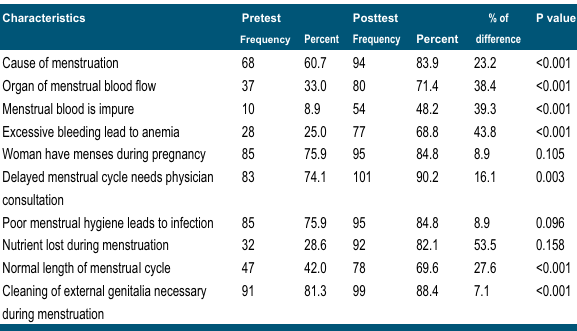
Table 1: Impact of Menstrual Educational Programme on Menstrual Hygiene Knowledge n=112